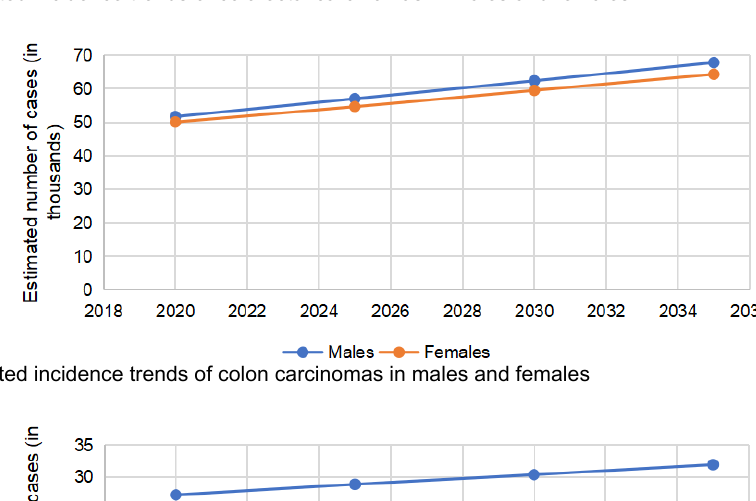
Figure 1. Predicted incidence trends of colorectal carcinomas in males and females